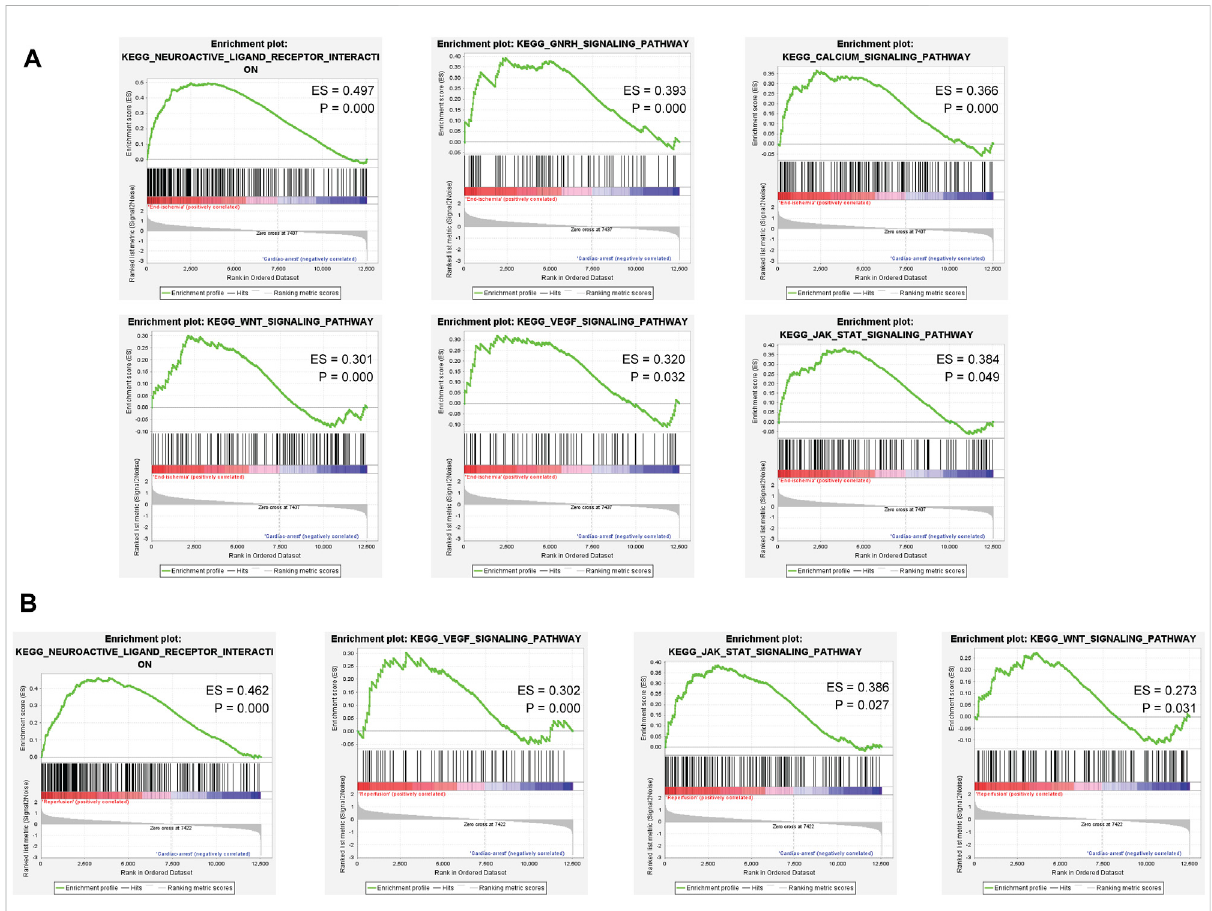
FIGURE 4 Gene set enrichment analysis of the ischemia and reperfusion samples. (A) Enriched pathways in ischemia samples. (B) Enriched pathways in reperfusion